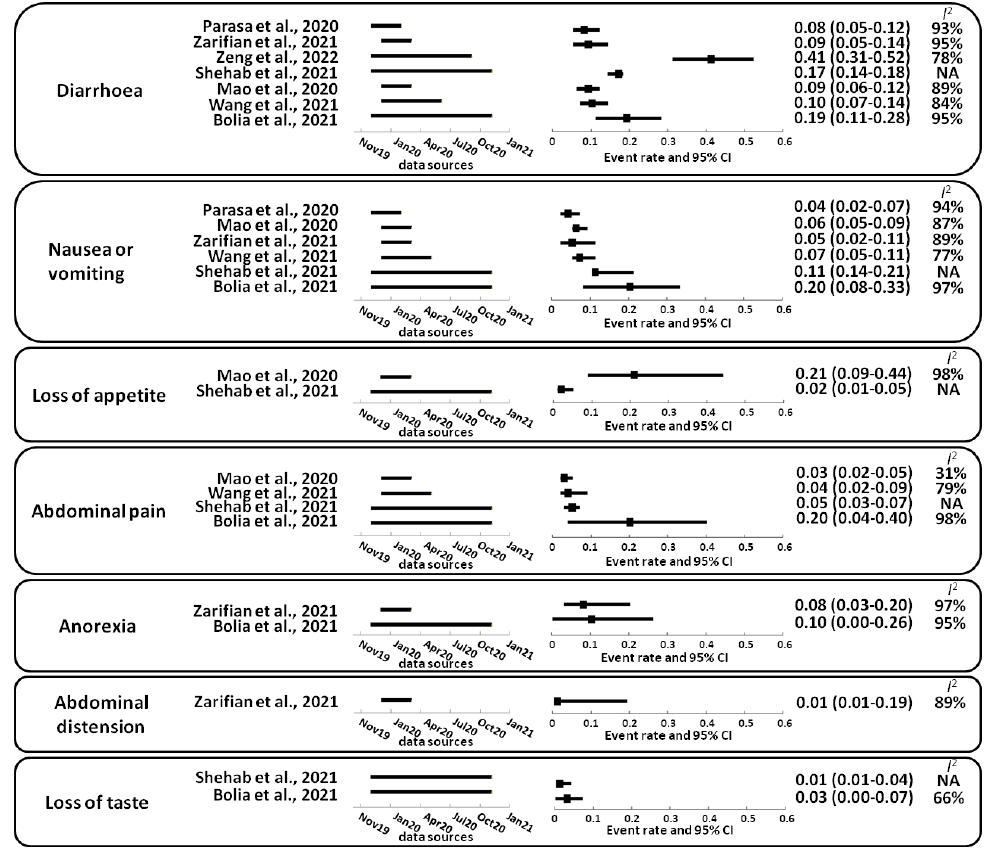
Figure 2. Gastrointestinal symptoms described in patients with COVID-19. The 95% confidence interval (95% CI); random-effects model estimate. For the I 2 statistic, the level of heterogeneity was defined as low (25–50%), moderate (50–75%), or high (>75%). Squares indicate proportions. NA, not available. References: Bolia et al., 2021 [23]; Mao et al., 2020 [21]; Parasa et al., 2020 [7]; Shehab et al., 2021 [12]; Wang et al., 2021 [30]; Zarifian et al., 2021 [19]; Zeng et al., 2022 [20].